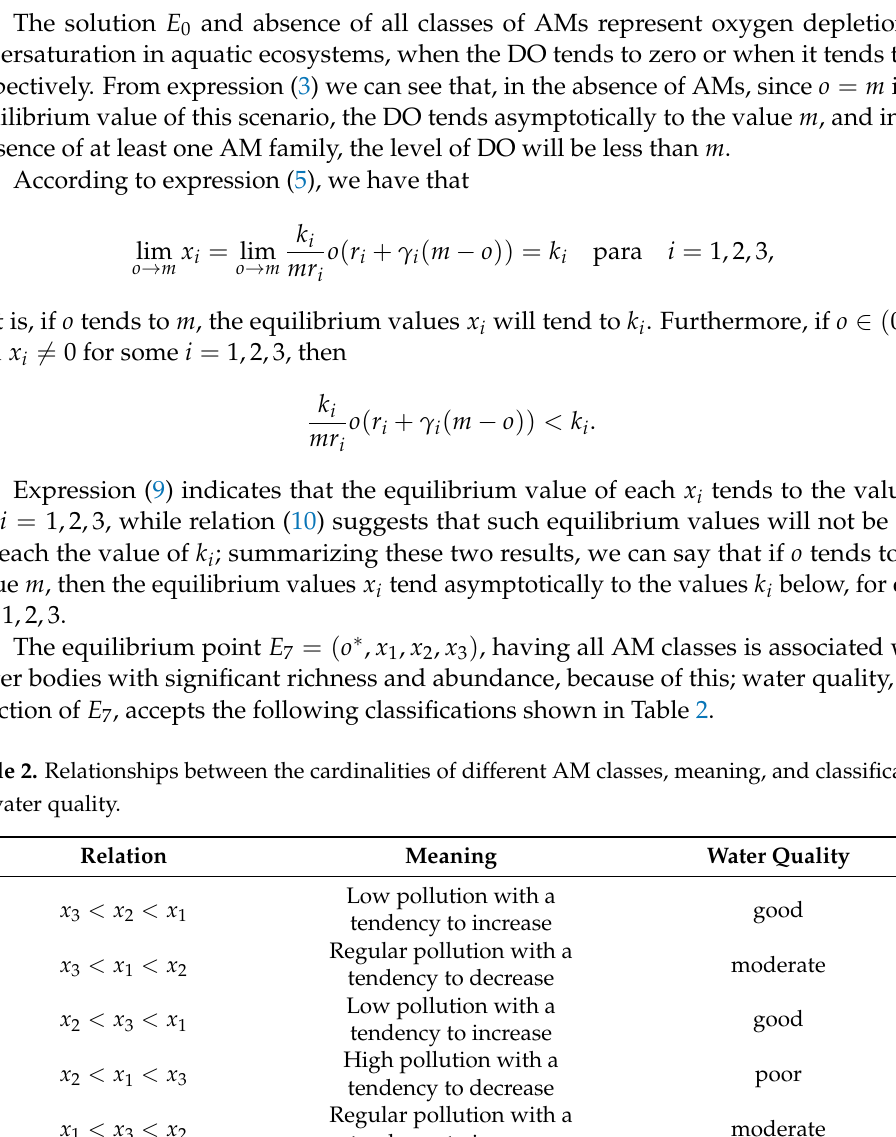
High pollution with a tendency to decrease